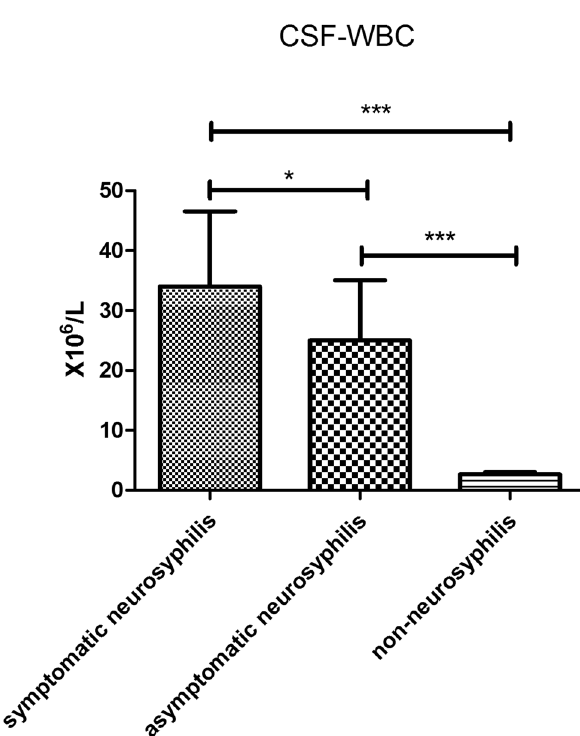
Figure 4: The comparison in IgG index among three groups. *** p <